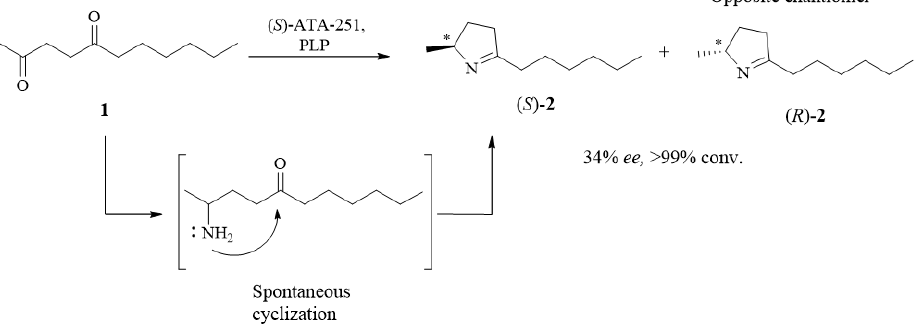
Figure 1. Reductive amination reaction of 1 by S -selective TA (ATA-251) or R -selective TA (ATA-117) to obtain enantiopure ( S )- 2 and ( R )- 2 , respectively. The products were obtained with excellent (>99%) yields and enantiomeric excess ( ee